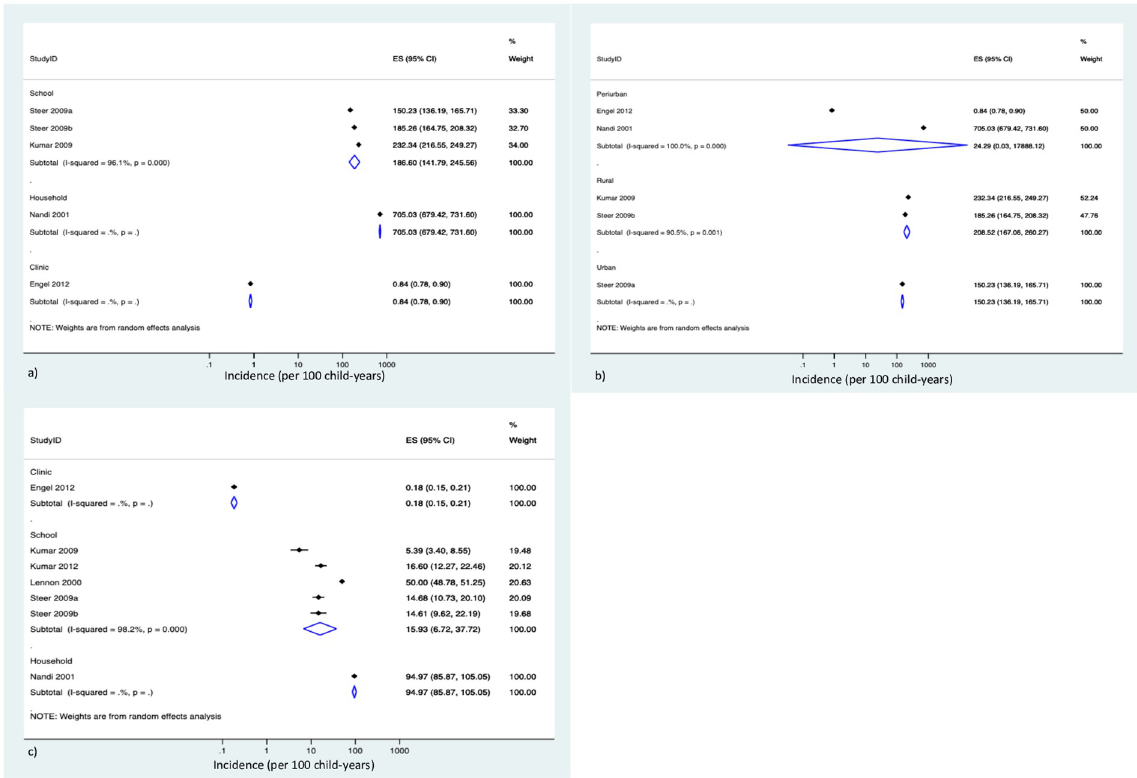
Fig 3. Subgroup analysis of pooled incidence rates: 3a) Sore throat IRs by study setting, 3b) sore throat IRs by rurality, and 3c) GAS pharyngitis by study setting. ES, effect size; CI, confidence interval.